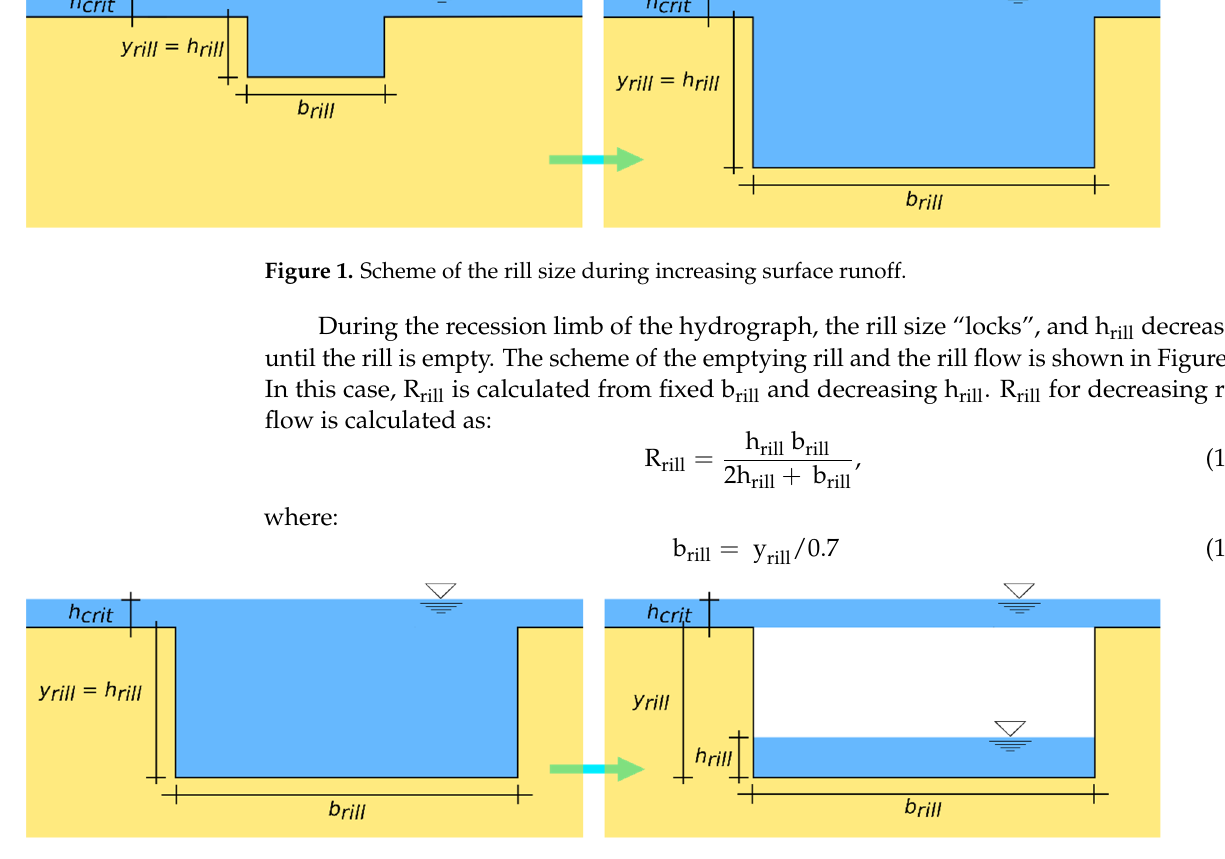
Figure 2. Scheme of the rill size during the recession limb of the hydrograph.